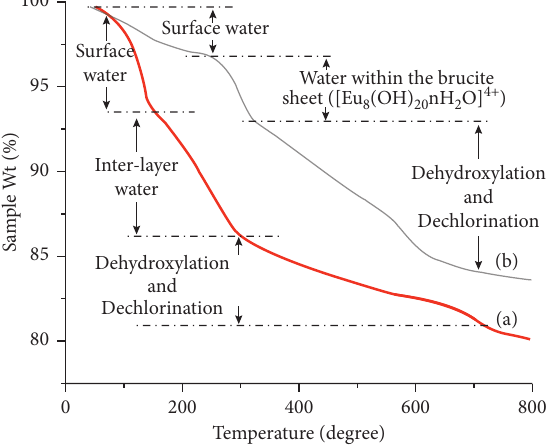
Figure 7: Thermogravimetric analysis of (a) LEuH-Cl aggregates and (b) LEuH-flocs nanosheets.